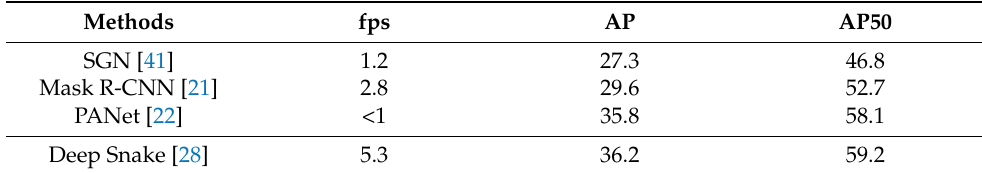
Table 3. Comparison of fps, AP, and AP50 results of animal